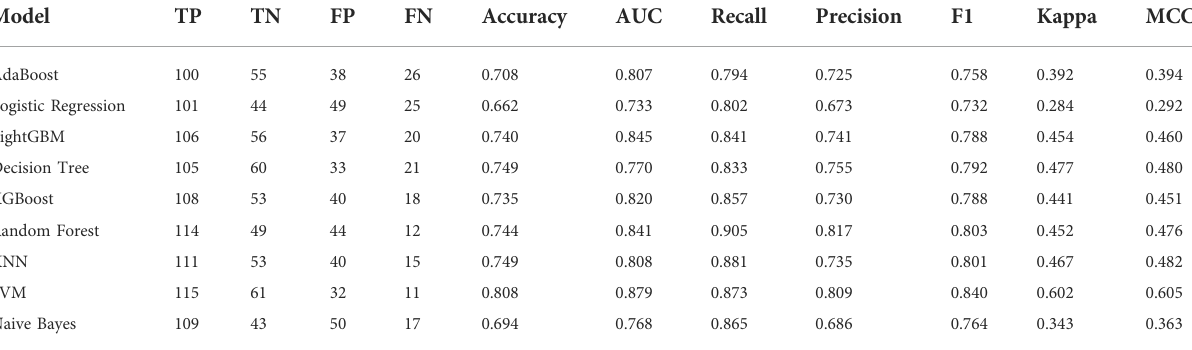
TABLE 1 Comparison of the diagnostic ef fi cacy of nine distinct machine learning models.